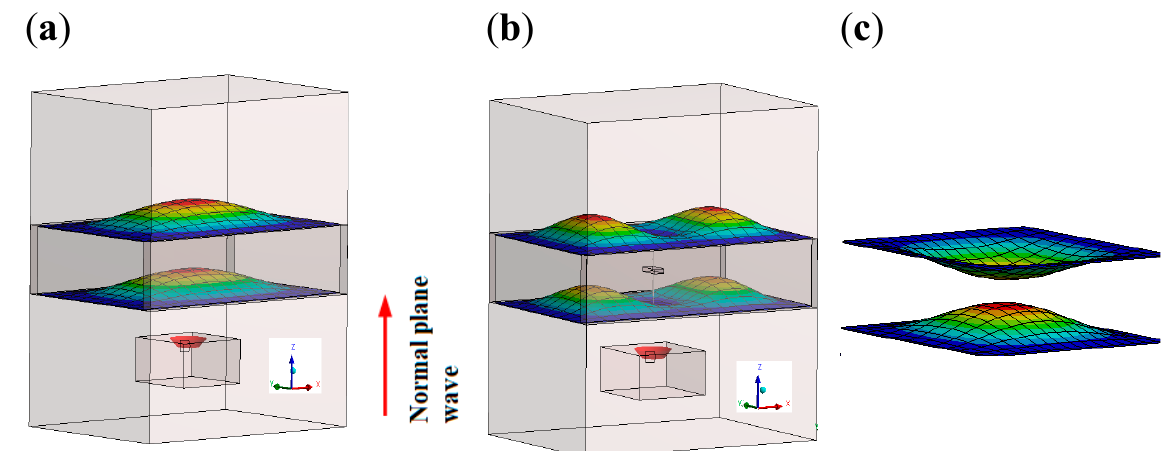
Figure 2. Finite element simulation results of double panel enclosed air cavity structure ( a ) first vibration mode of mass–air–mass (MAM) system ( b ) first vibration mode of mass–spring–damper (MSD) system ( c ) vibration mode at MAM resonance.